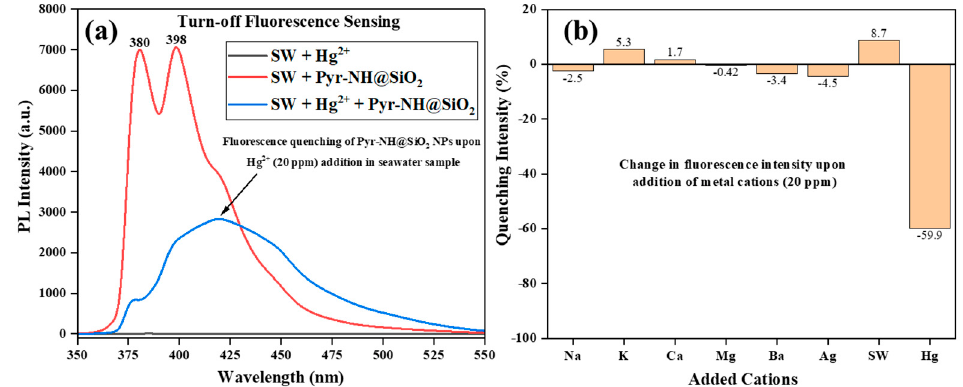
Figure 8. ( a ) PL emission spectra of real seawater (SW) samples which demonstrate the fluorescence quenching of Pyr-NH@SiO 2 NPs (20 ppm) upon addition of Hg 2+ ions (20 ppm); λ ex = 340 nm. ( b ) Selectivity of Pyr-NH@SiO 2 NPs against Hg 2+ ions upon addition of major cations of seawater, such as Na + , K + , Ca 2+ , Mg 2+ , Ba 2+ , and Ag + ions. All cations were used in the form of their chloride salts.